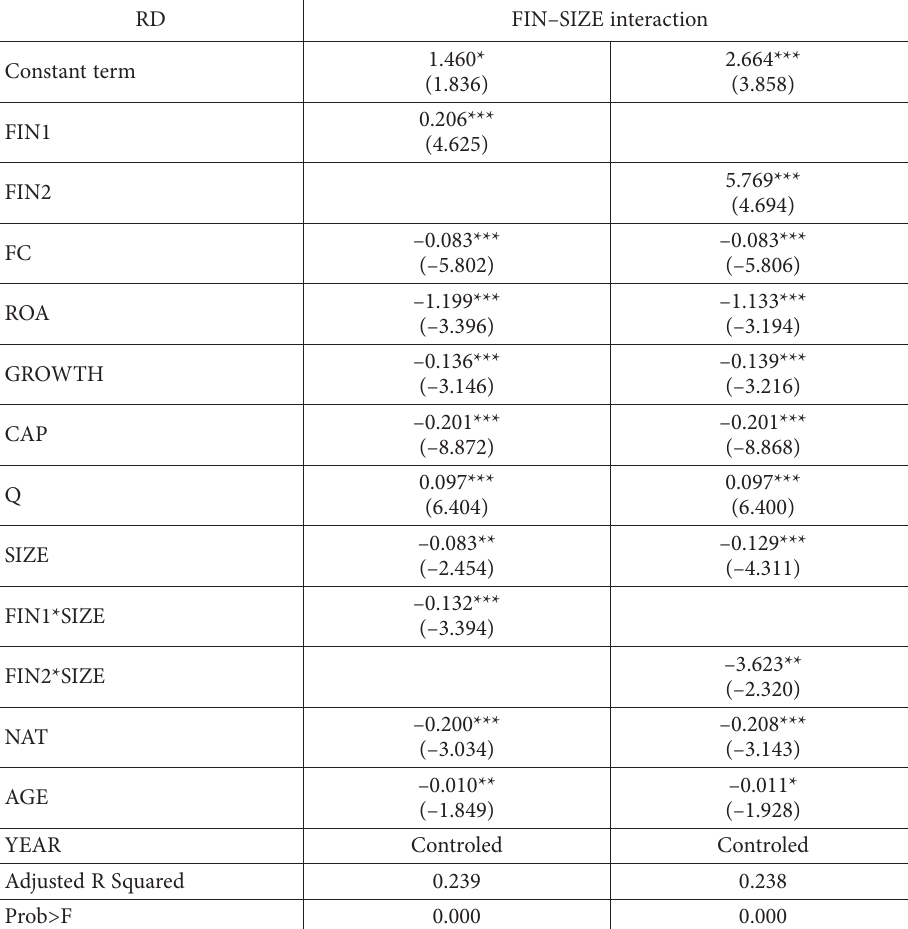
Table 9. Results of Model